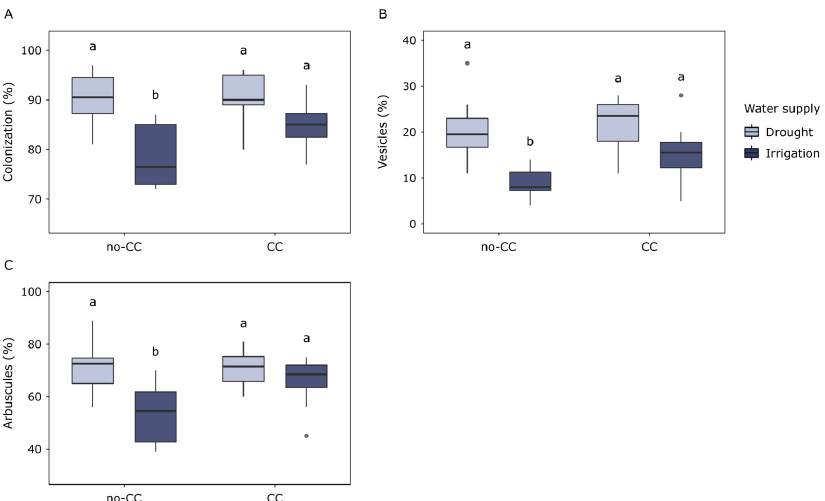
Figure 1. Arbuscular mycorrhizal fungi (AMF) colonization of corn roots in response to cover